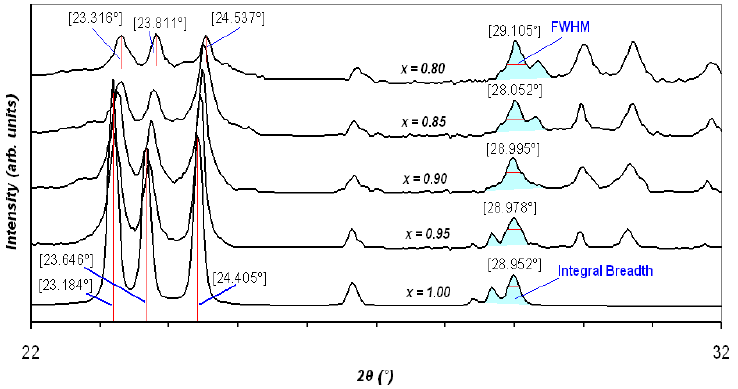
Figure 3. A sample of shift in peak position and FWHM variations in XRD